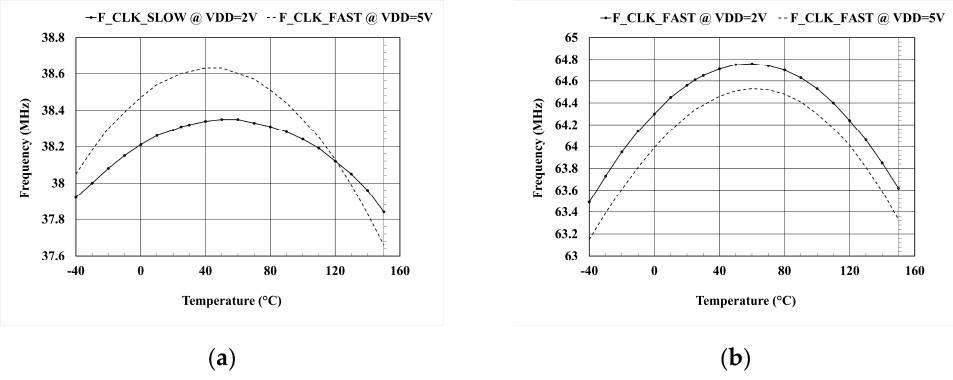
Figure 8. Frequency variation with temperature and VDD in corners. ( a ) Slow; ( b ) Fast.